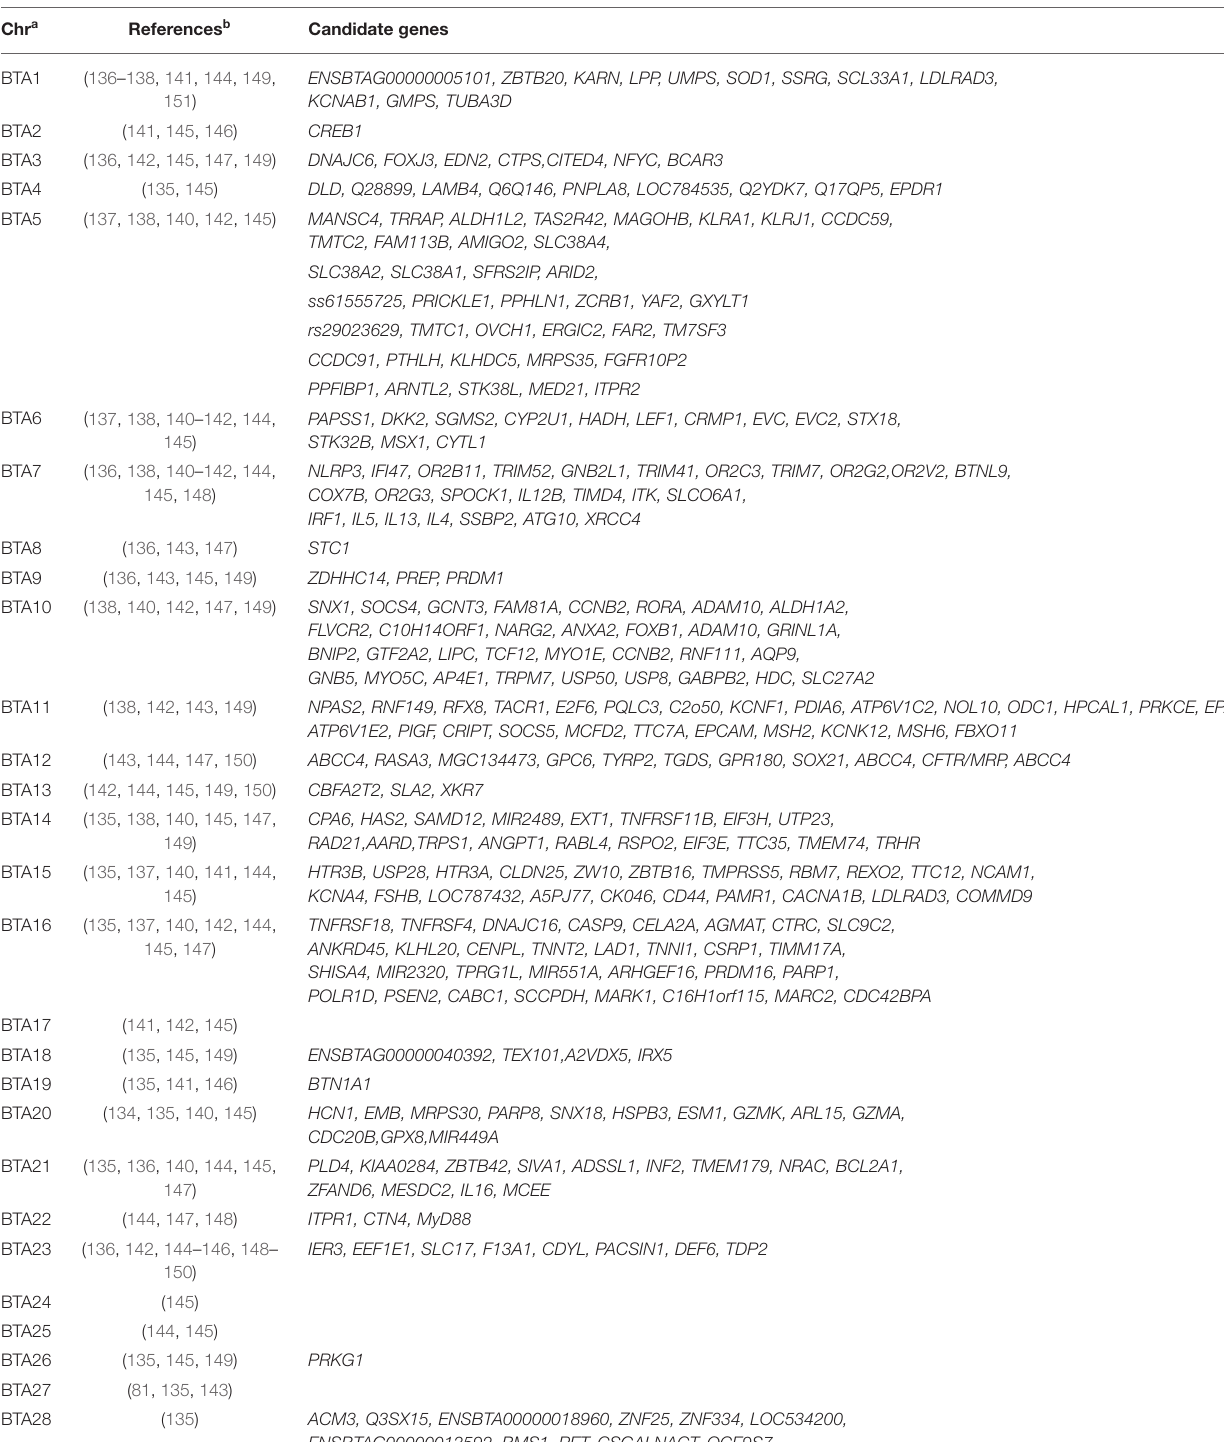
TABLE 1 | Chromosomes with SNPs and candidate genes statistically associated with resistance to Johne’s disease in cattle. Chr